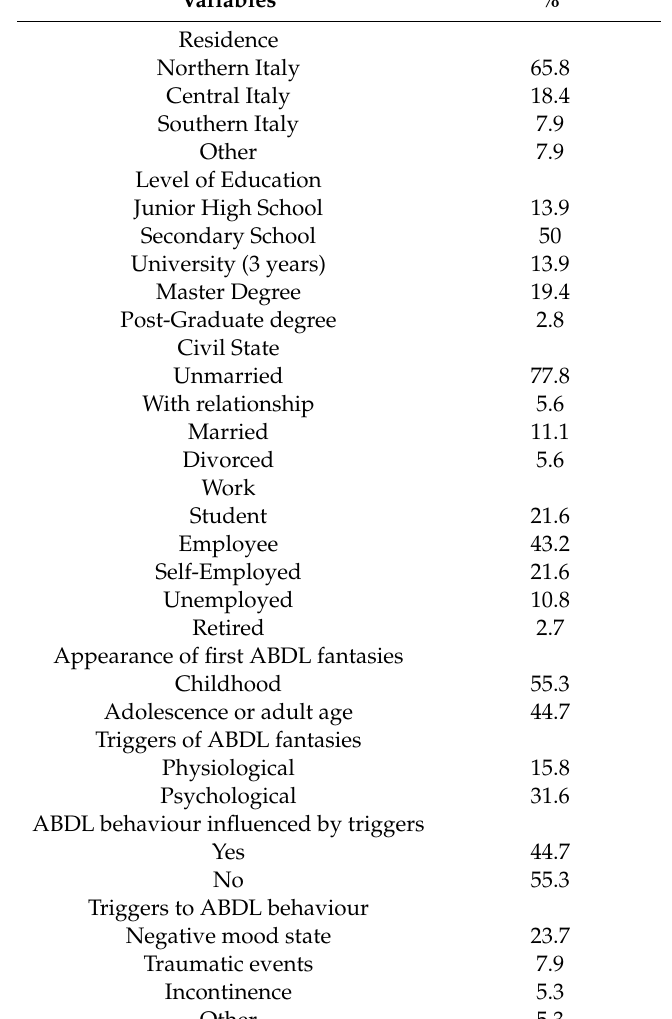
Table 1. Demographic characteristics and descriptive statistics. Adult Baby-Diaper Lovers